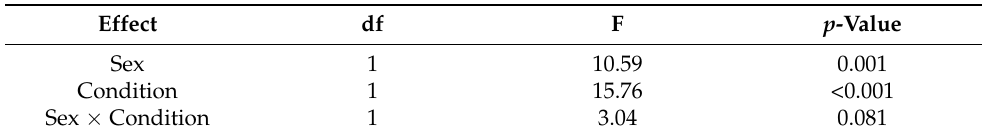
Table 11. Significant Effects on Change in Physiological Arousal. Only non-affective touches were